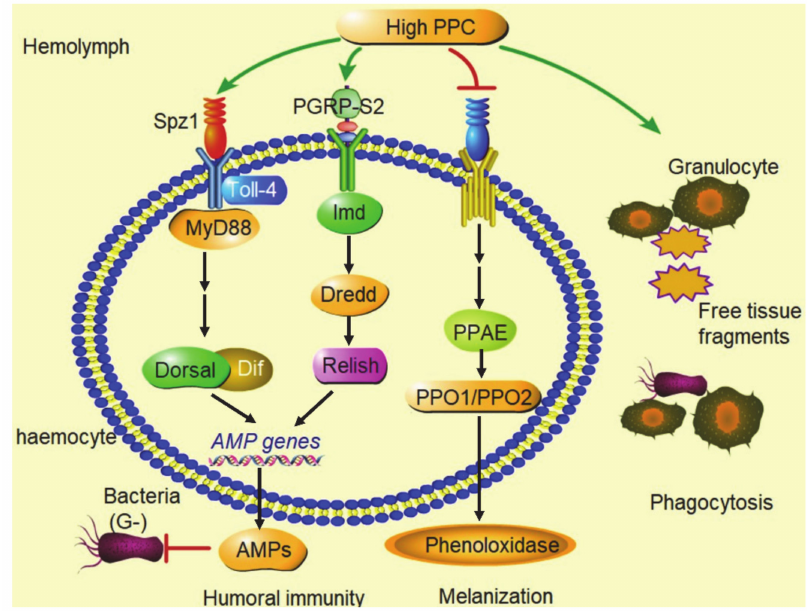
Figure 7. Summary graph. High PPC inhibited phenoloxidase production and melanization of hemolymph in silkworm; high PPC induced granulocytes to phagocytize free tissue fragments in hemolymph, such as dissociated fat body cells; high PPC activated the Toll pathway and Imd pathway in NF- κ B signaling, and promoted the large expression of AMPs